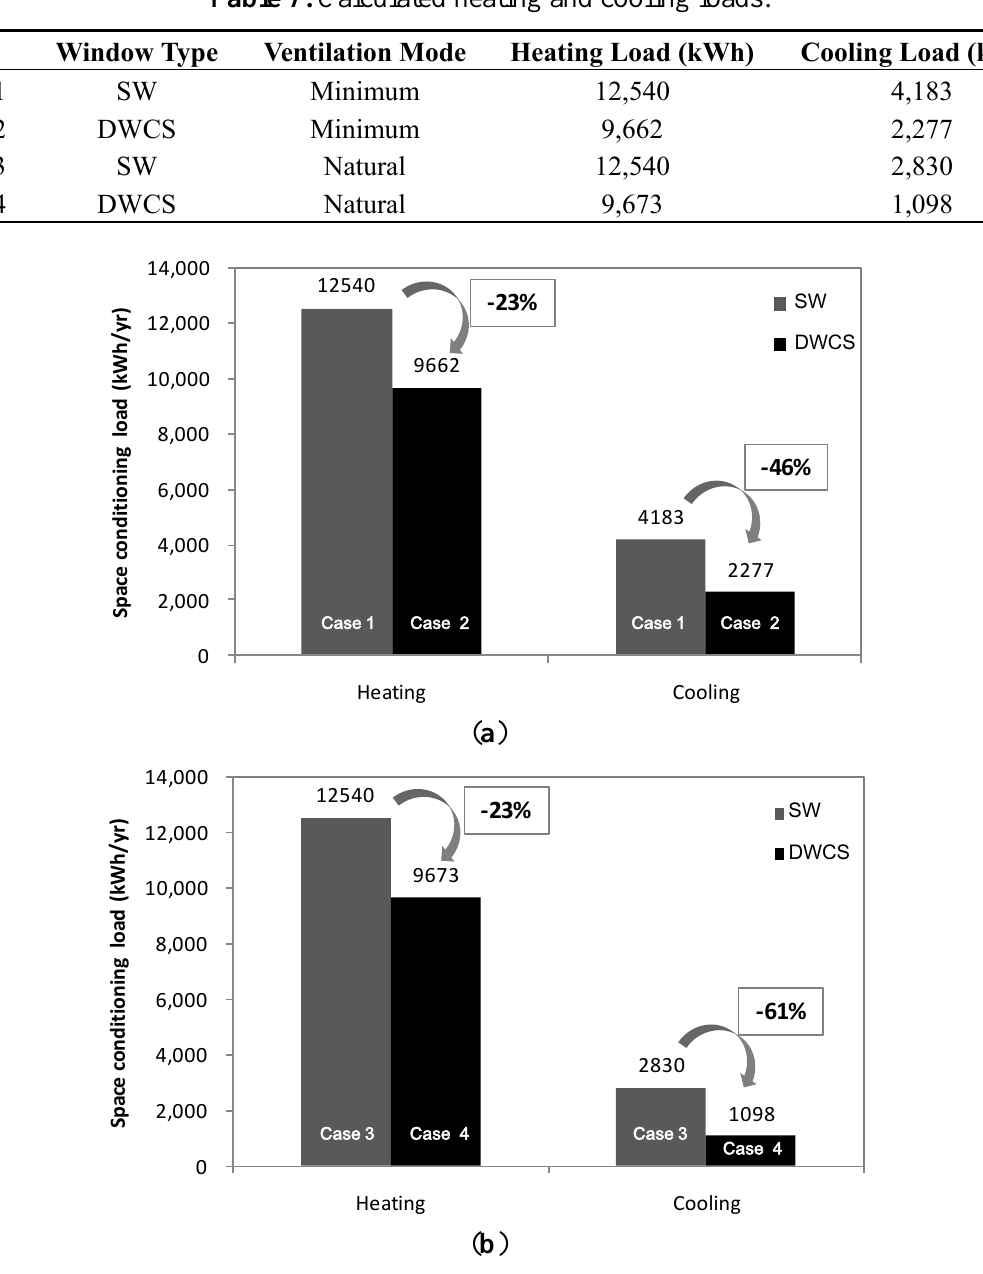
Table 7. Calculated heating and cooling loads.